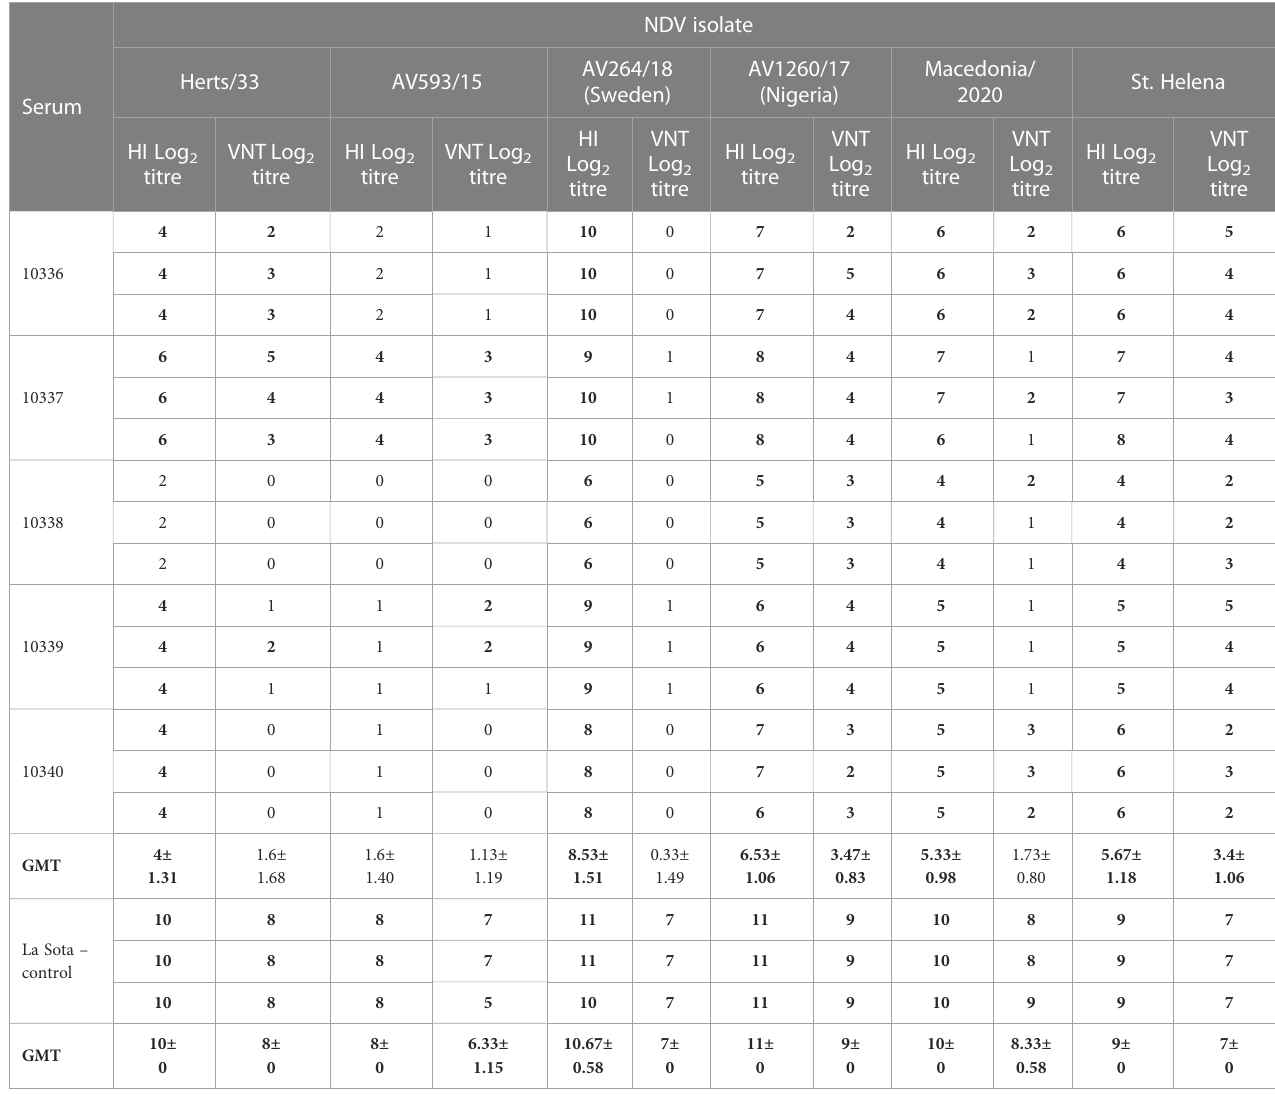
TABLE 3 Serology results for hemagglutination inhibition and virus neutralization tests against six Newcastle disease viruses, with positive titres indicated in bold.